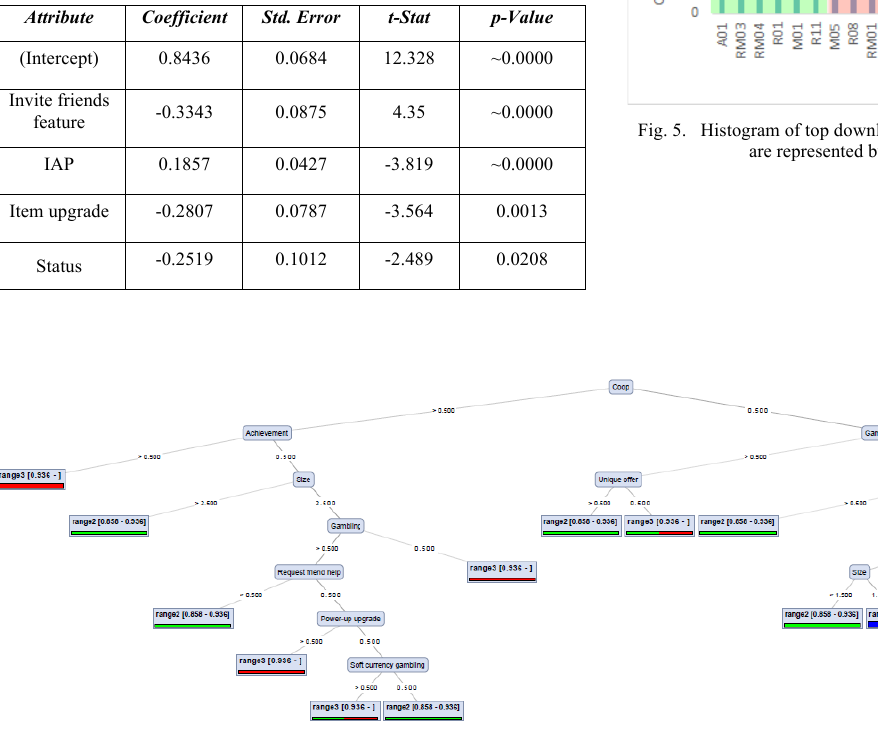
Fig. 4. Histogram of top grossing games using coefficient. Game features are represented by ID presented on session III. TABLE IV.